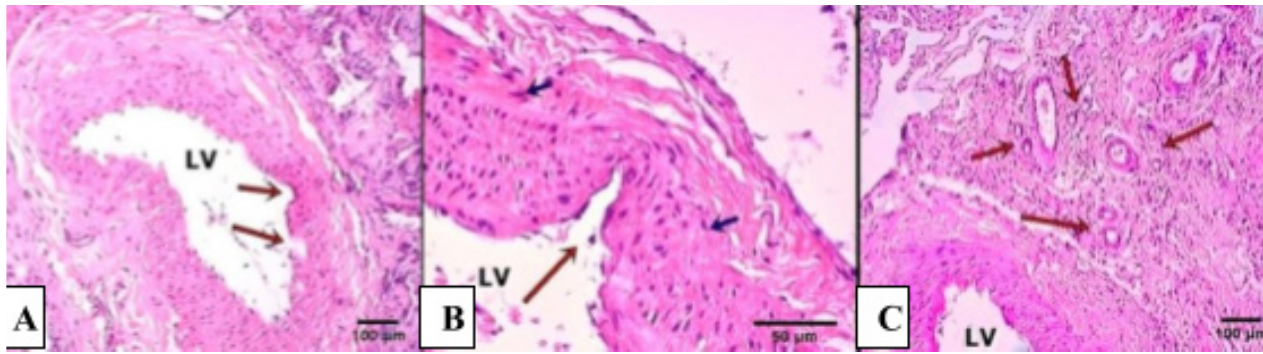
Fig. 3 - Photomicrographs of the region of surgical specimens extracted from samples of the TachoSil® Group 7 days after the operation, stained with haematoxylin and eosin. The arrows in A (10× magnification) point to discontinuity of the vascular wall with a 40× increase in B. The presence of leukocytes and fibroblasts can also be observed. Note, through the indication of the arrows in C (10× magnification), the discreet presence of microcirculation, possibly originating from the neovascularization process. LV=lumen of the vessel.